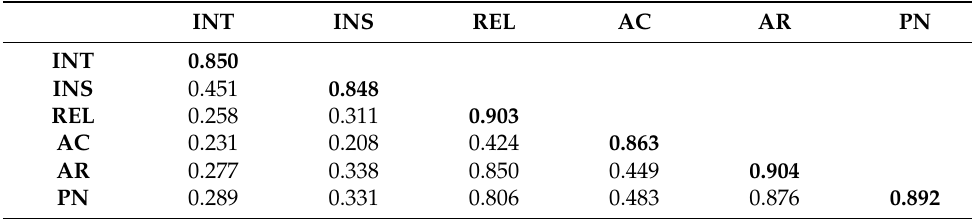
Table 4. Discriminant validity for the variables in the